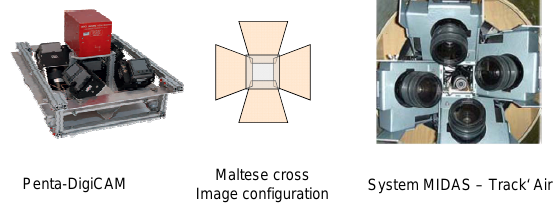
Figure 2: Oblique multi head medium format camera systems (Maltese Cross)